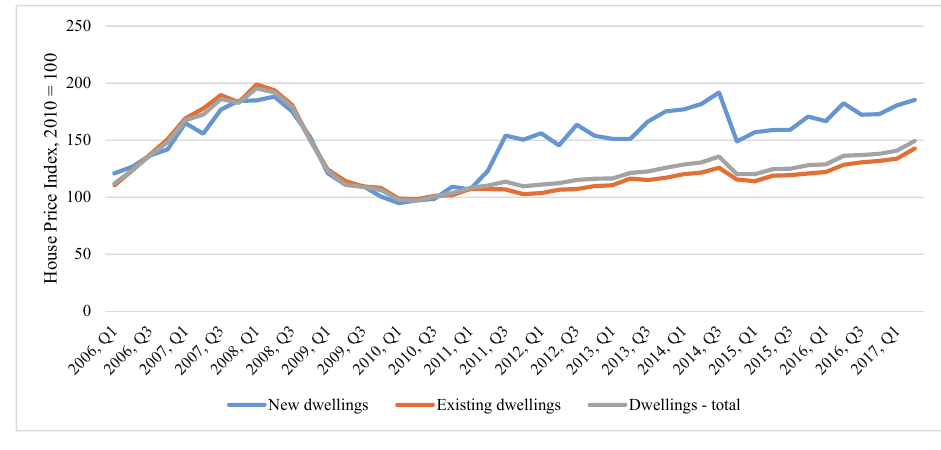
Fig. 2 . House Price Index in Latvia from 2006 Q1 to 2017